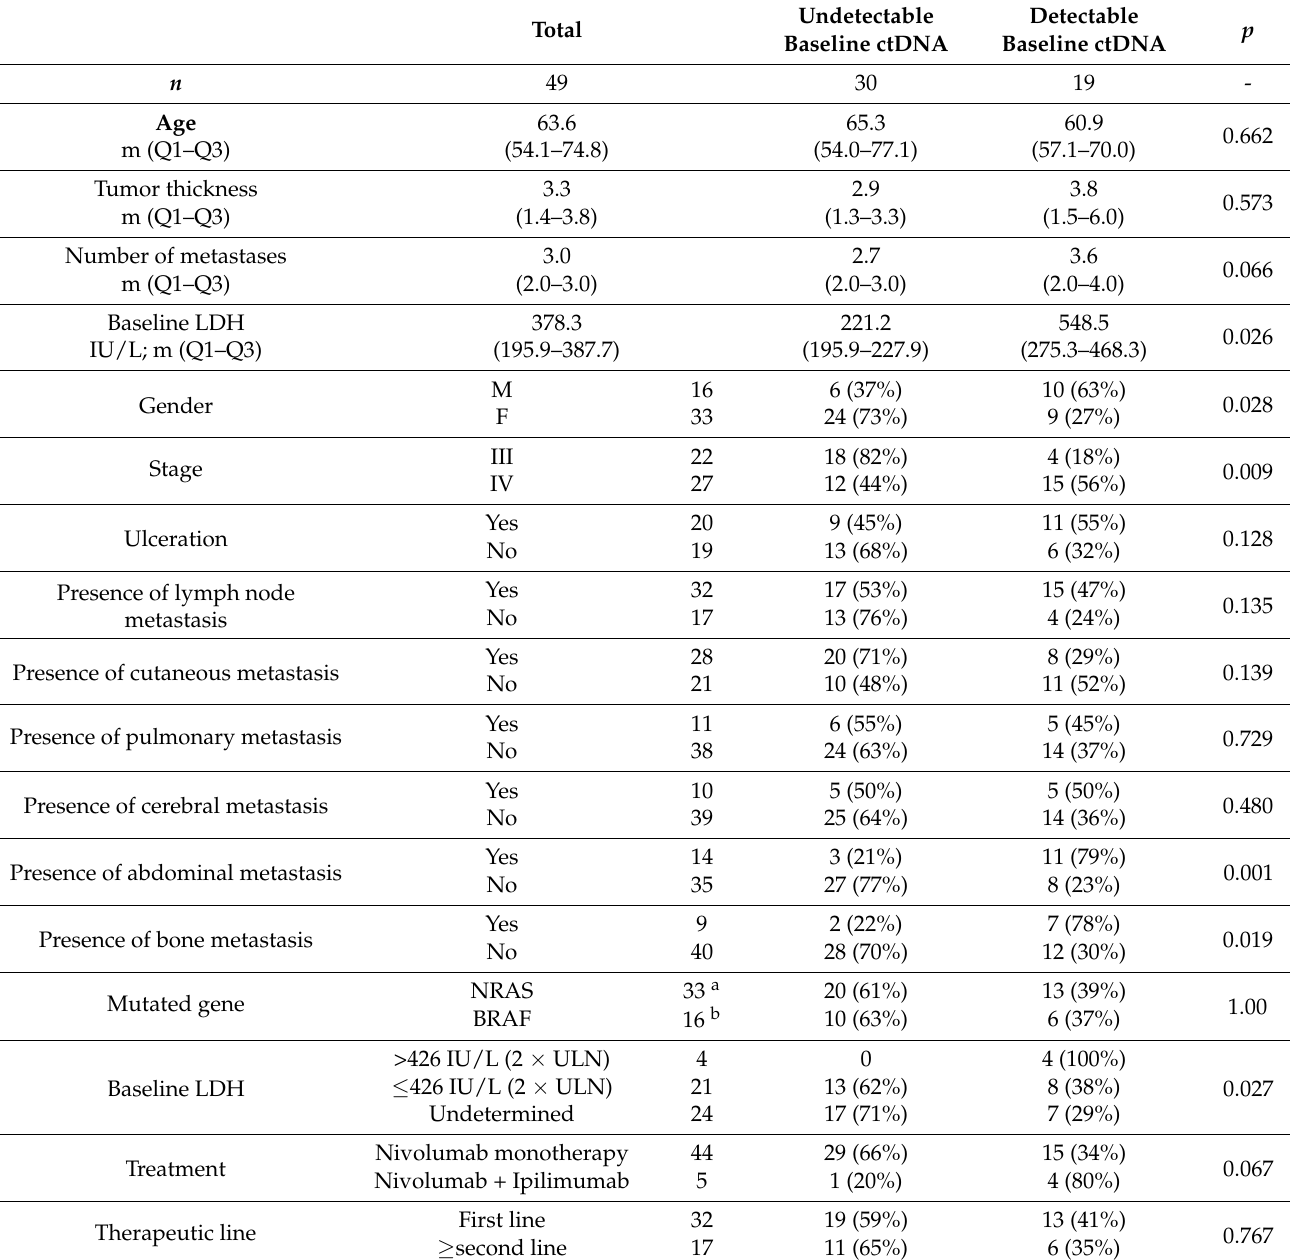
Table 2. Patient characteristics in the validation